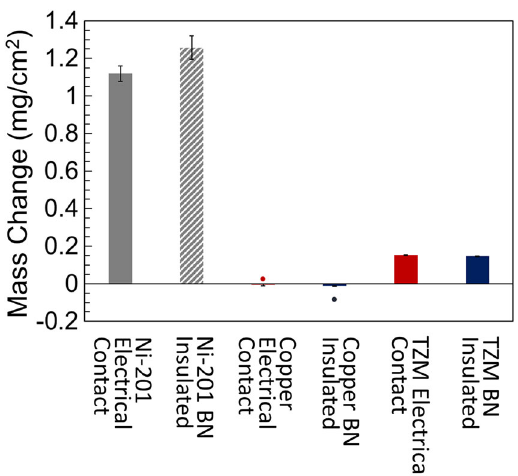
Fig. 2 Post-corrosion mass change results. TZM and copper results from this study are plotted along with results from Falconer et al. 7 shown in gray for comparison to the Ni-201 sample sets studied in their experiments. Error bars are standard deviations between samples.